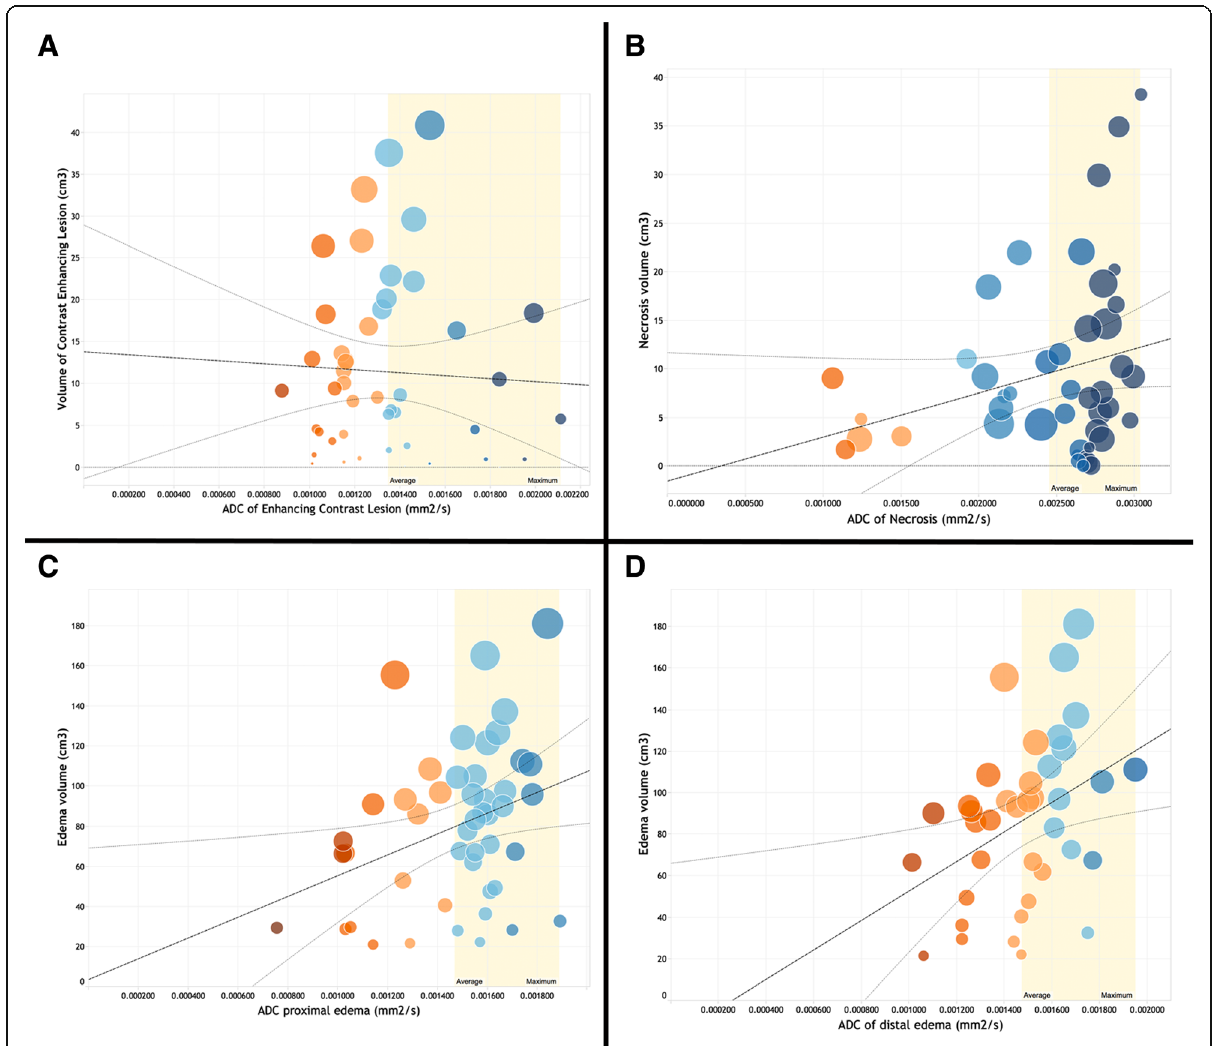
Fig. 3 Scatterplots with regression lines of similar association between ADC values and tumour region volumes; a yellow colour band indicates ADC values above the mean. a Contrast-enhancing lesion. b Tumour. c Proximal oedema. d Distal